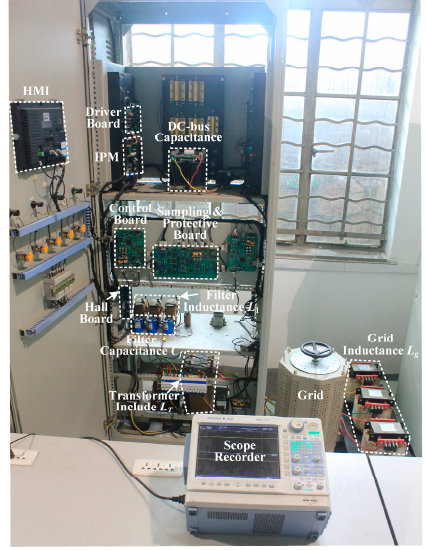
Figure 10. Prototype of the 10 kW three-phase LCL-type grid-connected converter.